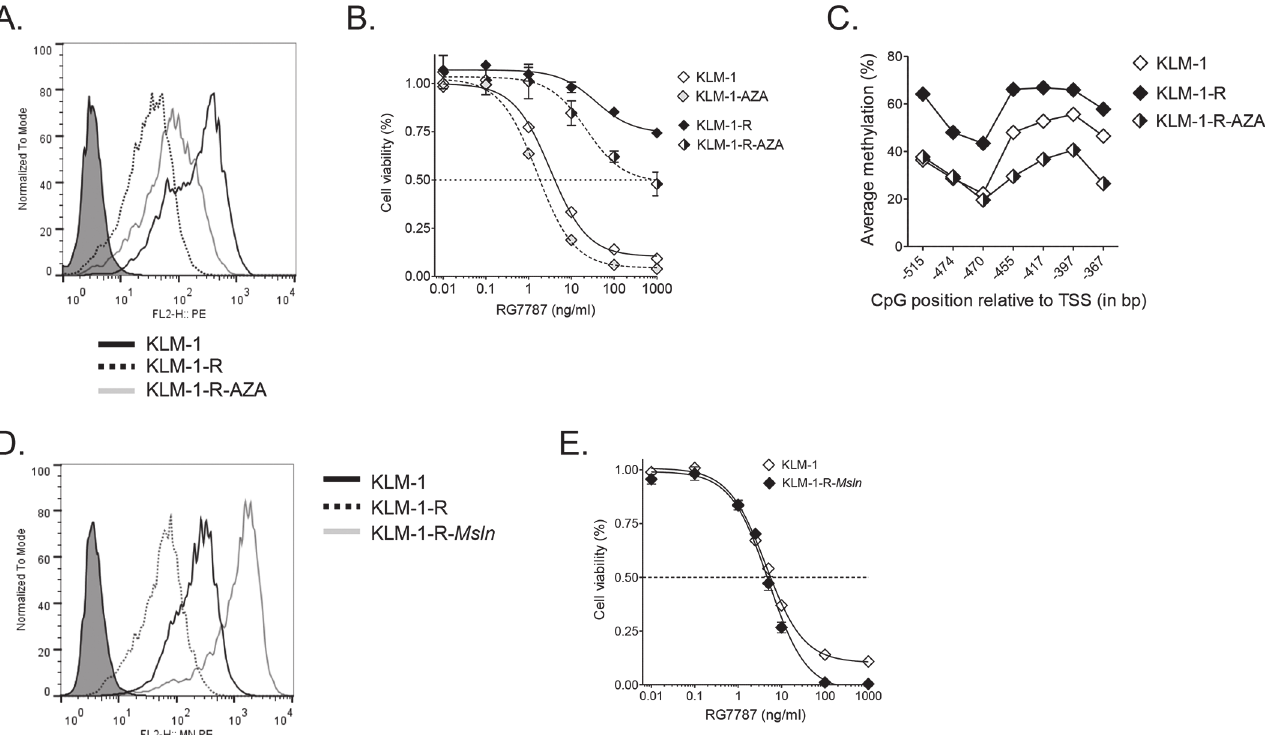
Fig 3. Mesothelin downregulation is associated with CpG hypermethylation and mesothelin transfection restores sensitivity to of KLM-1-R to RG7787. A : AZA leads to a 2.8-fold increase of mesothelin surface expression in resistant KLM-1 (KLM-1-R). Flow cytometry histogram of KLM-1, KLM-1-R, and KLM-1-R-AZA. Filled histograms represent secondary antibody controls. B : Three weeks of incubation with AZA, a DNA methyltransferase inhibitor, increases sensitivity to RG7787. KLM-1, KLM-1-R, and the AZA-treated cells (KLM-1-AZA and KLM-1-R-AZA) were treated for 72 hrs with RG7787. Growth inhibition was evaluated with an ATP cell viability assay. Dotted lines represent AZA-treated cells. C : CpGs in a region upstream of the mesothelin transcription start site are more methylated in KLM-1-R than in KLM-1. Three weeks of incubation with AZA decreases methylation in KLM-1-R cells. The analyzed region is located at chr16:808890-808742 and spans 147 bp and seven CpGs. D : Mesothelin transfection in KLM-1-R results in significant overexpression of mesothelin compared to KLM-1 (5-fold) and KLM-1-R (23-fold). Flow cytometry surface mesothelin levels in KLM-1, KLM-1-R and mesothelin-transfected resistant cells (KLM-1-R- Msln ). E : Mesothelin overexpression in KLM-1-R restores sensitivity to RG7787. KLM-1 and KLM-1-R- Msln cells were incubated for 72 hrs with RG7787. Growth inhibition was evaluated with an ATP cell viability